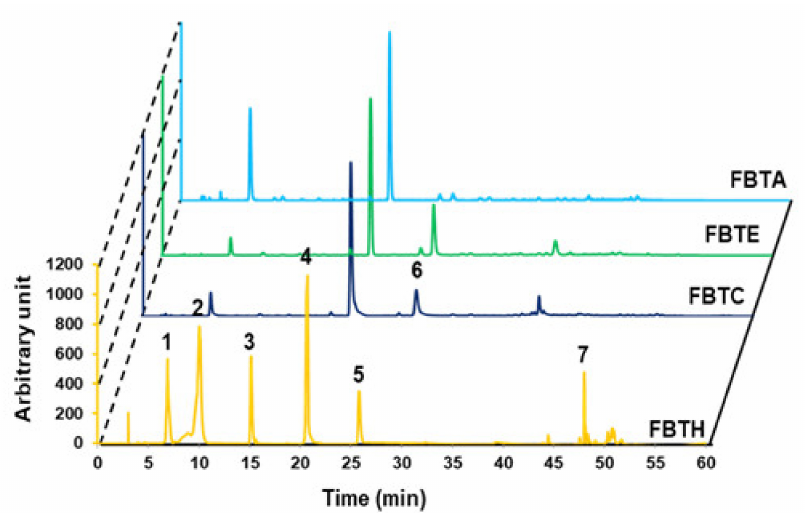
Figure 1. Analytical analysis by HPLC. HPLC analysis was performed to confirm the food ingredient in FBTH. The detailed conditions for high-performance liquid chromatography are explained in the Materials and Methods section. HPLC (absorbance at 280-nm)—profile of phenolic standards and FBTH. Peaks: gallic acid (1); theaflavin (2); theobromine (3); caffeine (4); epicatechin (5); epi- gallocatechin gallate (EGCG) (6); quercetin (7). The injection volume was 20- µ L, and the flow rate was maintained at 0.8-mL/min. All tests were performed in